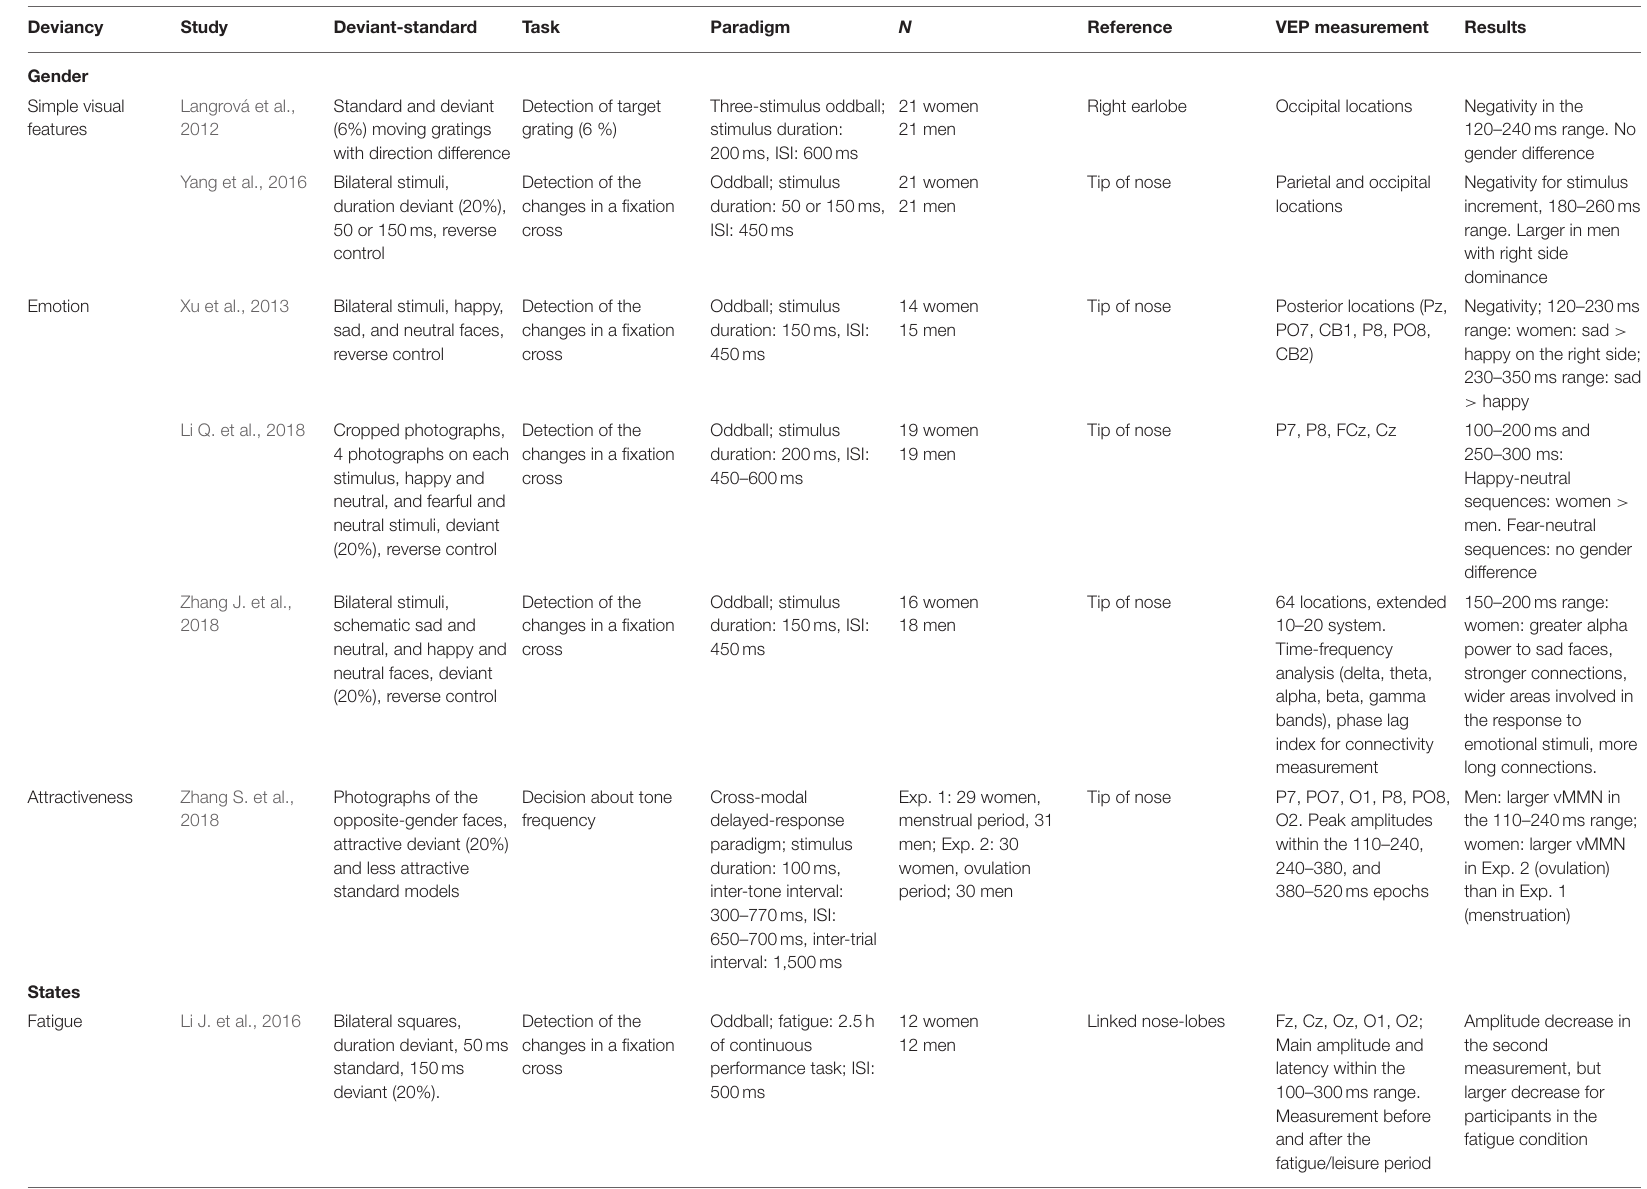
TABLE 1 | A summary of the review